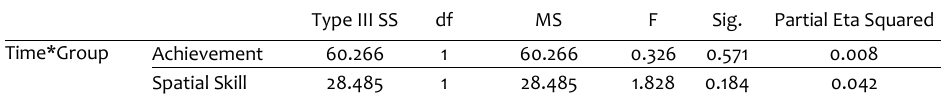
Table 2. Tests of within-subjects contrasts